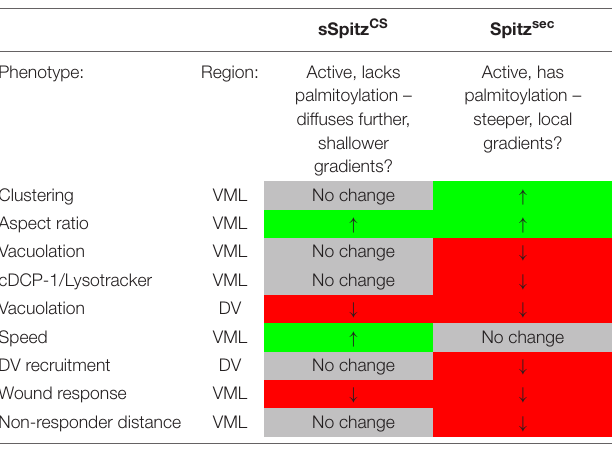
TABLE 1 | Summary of Spitz-induced macrophage